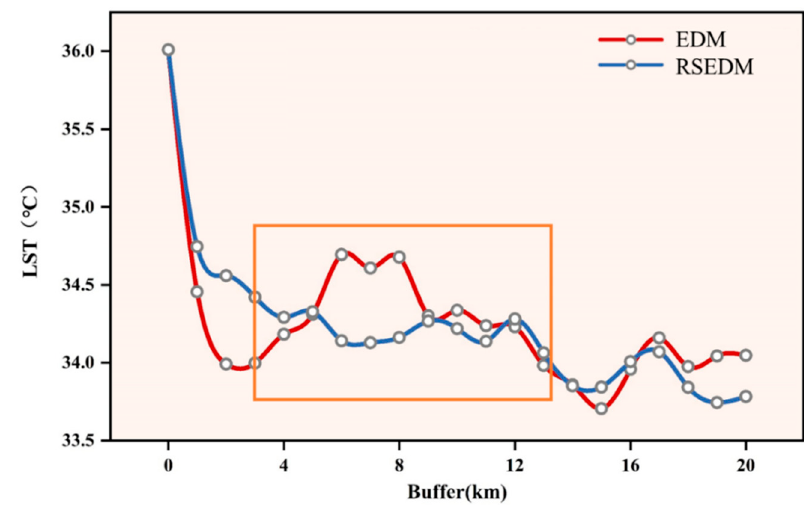
Figure 7. Land surface temperature curves of Nanjing obtained by the rotational-scan exponential decay model and exponential decay model, respectively. The temperature of the 0 km buffer expresses the mean temperature of the urban area.